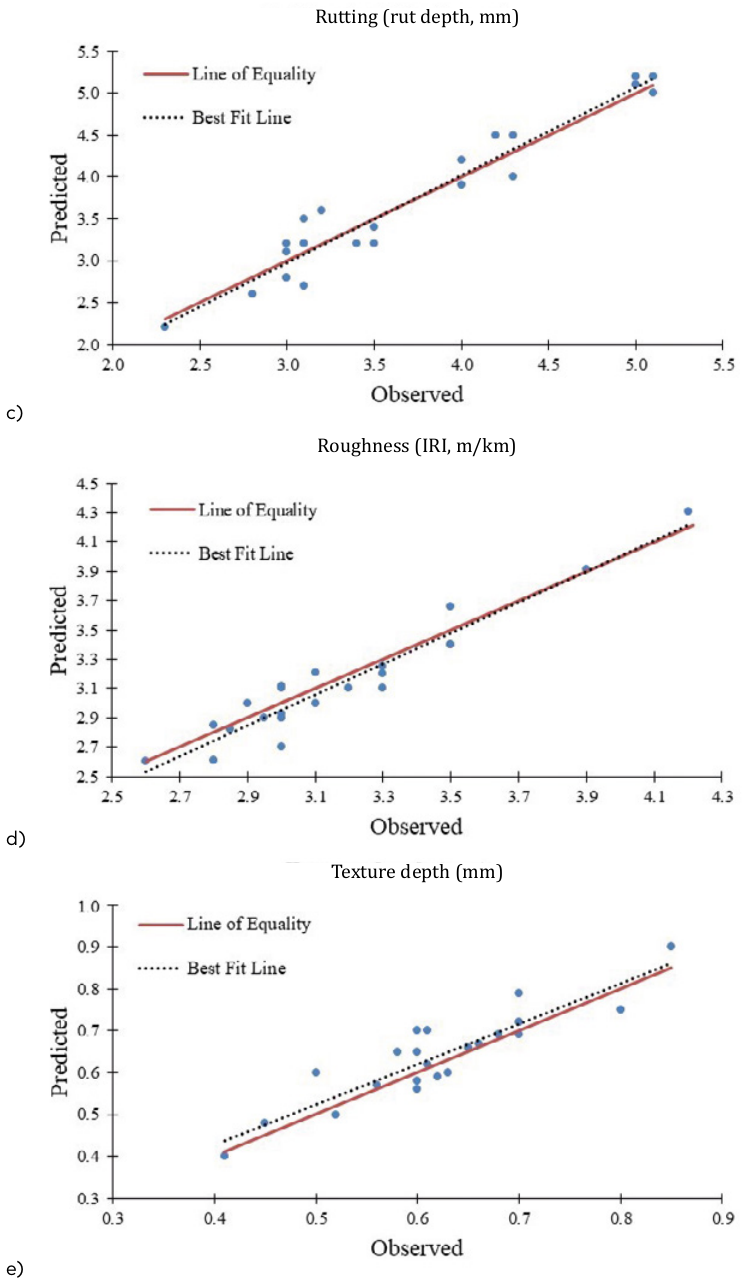
Figure 9. Predicted and observed distresses (line of equality is shown as a firm line, and the best-fit line is shown as